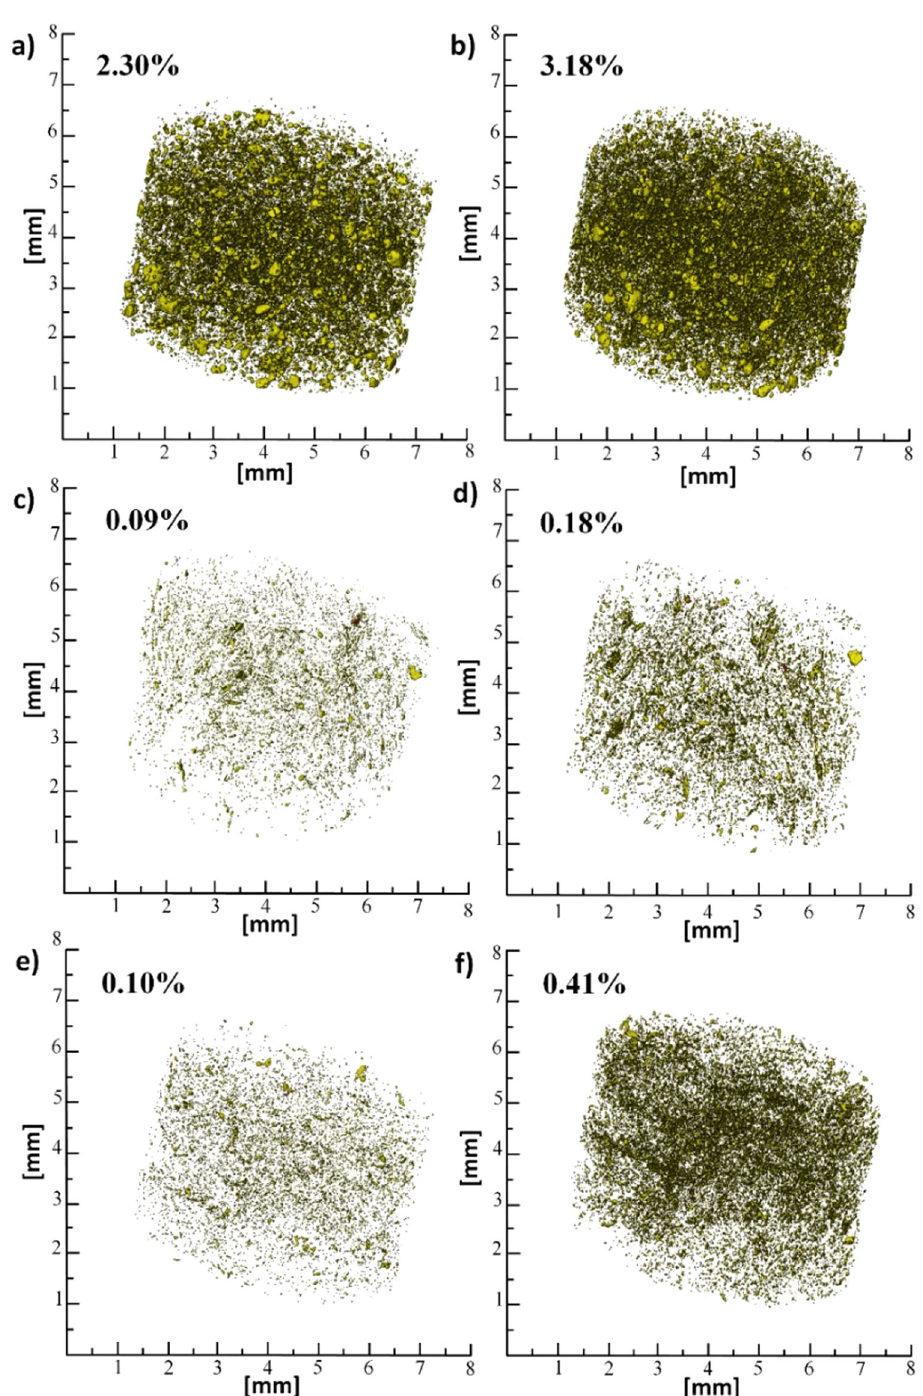
Fig. 8 3D images of inclusions in samples #3 before and after storage. a , b Torre fi ed pellet (tor_sample3) before storage ( a ) and after 1 month of storage ( b ). c , d Wood pellet type I (wp1_sample3) before storage ( c ) and after 1 month of storage ( d ). e , f Wood pellet type II (wp2_sample3) before storage ( e ) and after 1 month of storage ( f ). Yellow colour represents 3D inclusions. Percentages shown in the fi gure indicate the inclusion-to-pellet volume ratio expressed in %. See Supplementary Table 7 for detailed information on inclusion-to-pellet volume ratio